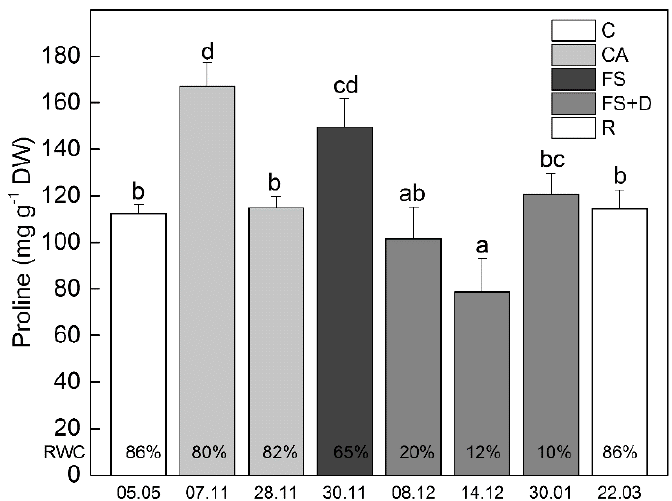
Figure 5. Changes in leaf proline content (mg g − 1 DW) of Haberlea rhodopensis after exposure to low temperatures during cold acclimation (CA, period: 7–28 November), freezing stress (FS, − 10 ◦ C, 30 November), freezing-induced desiccation (FS + D, period: 8 December–30 January) and after recovery of plants in early spring (R; period: 22 March) under natural ex situ environmental conditions. Percentages at the bottom of the columns show the relative water content (RWC) of leaves at each time point. Data represent the mean of n = 6. The same letters within a graph indicate no significant differences assessed by Fisher ’ s LSD test ( p ≤ 0.05) after performing ANOVA.